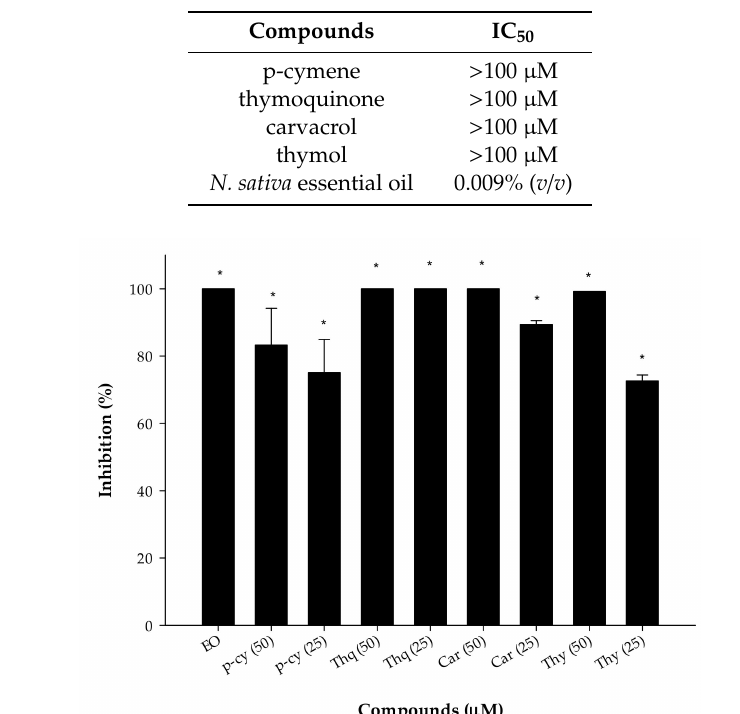
Table 1. Cytotoxic e ff ects of Nigella sativa essential oil (EO) and its bioactive compounds on HeLa cells.